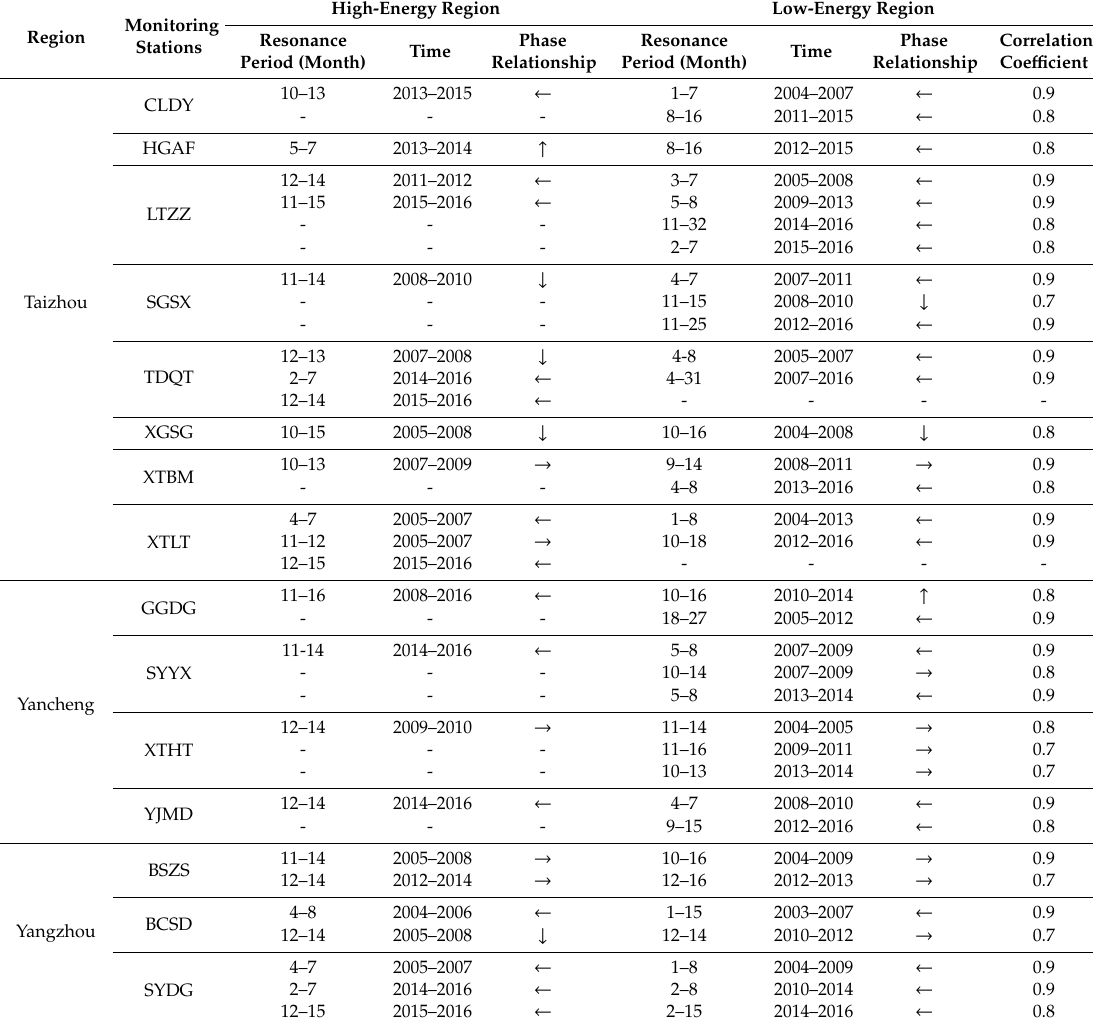
Table 8. Correlation between the CWQI and the amount of diversion water.